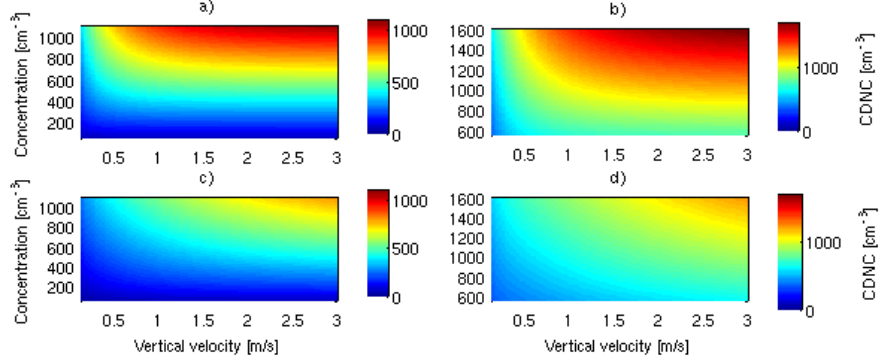
Figure 2: The absolute cloud droplet number concentrations from the first experiment. a) and c) Fig. 2. The absolute cloud droplet number concentrations from the first experiment. (a) and (c) show the CDNCs for unrestricted and show the CDNC's for unrestricted and reallocating modal models for the no background case. reallocating modal models for the no background case. Panels (b) and (d) for the case with background aerosol. Panels b) and d) from the case with background aerosol.